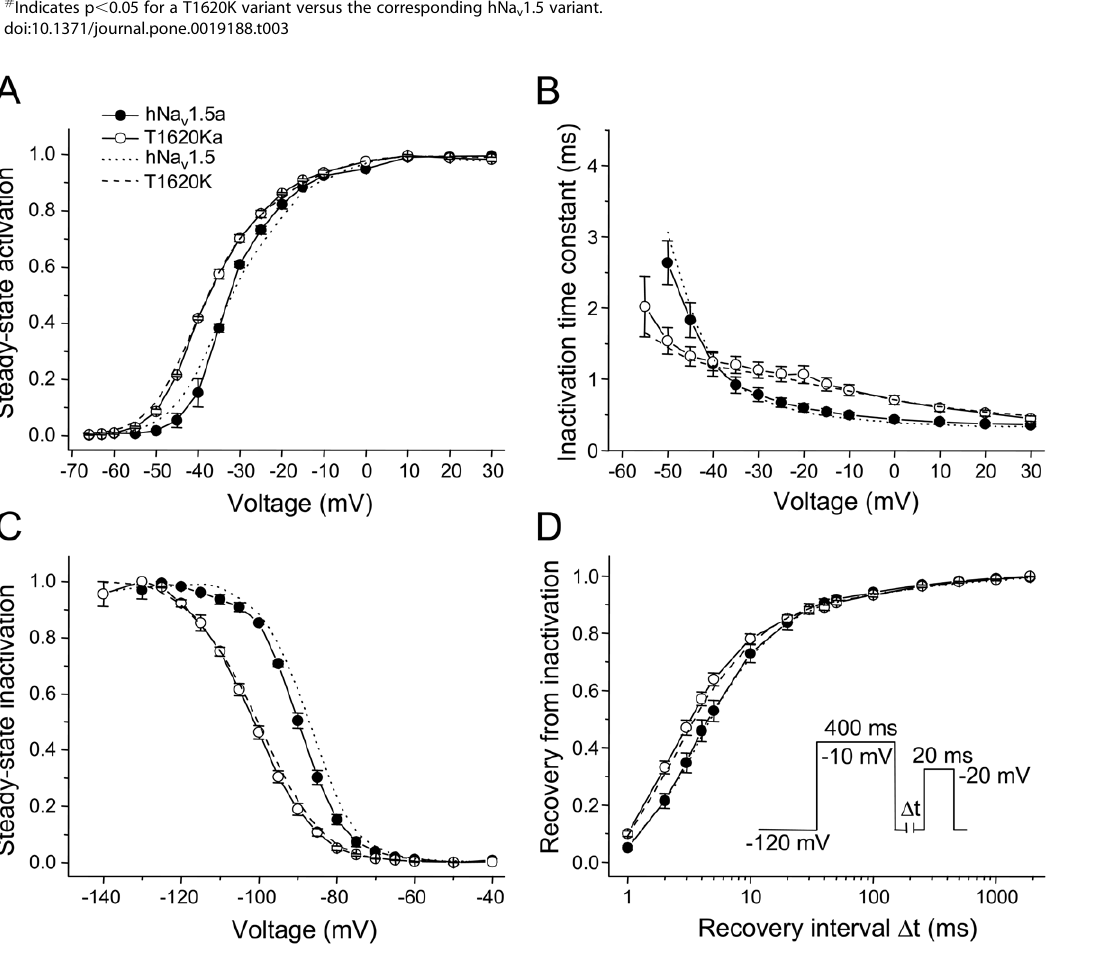
Figure 3. Electrophysiological properties of spliced hNa v 1.5a and T1620Ka channels. Steady-state activation (A), time constants of inactivation (B), steady-state inactivation (C) and recovery from inactivation (D) were indistinguishable in hNa v 1.5a and hNa v 1.5 (dotted). Mutation T1620K produced similar defects in both the spliced and non-spliced (dashed) background (see Tables 2 and 3 for data evaluation and statistics). doi:10.1371/journal.pone.0019188.g003 PLoS ONE |